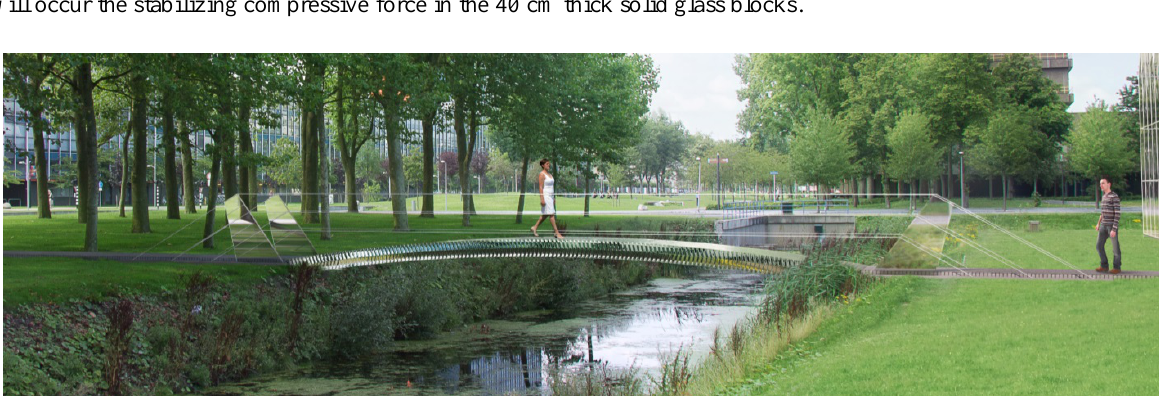
Fig. 1 artist impression of the final ‘Glass Block Arch